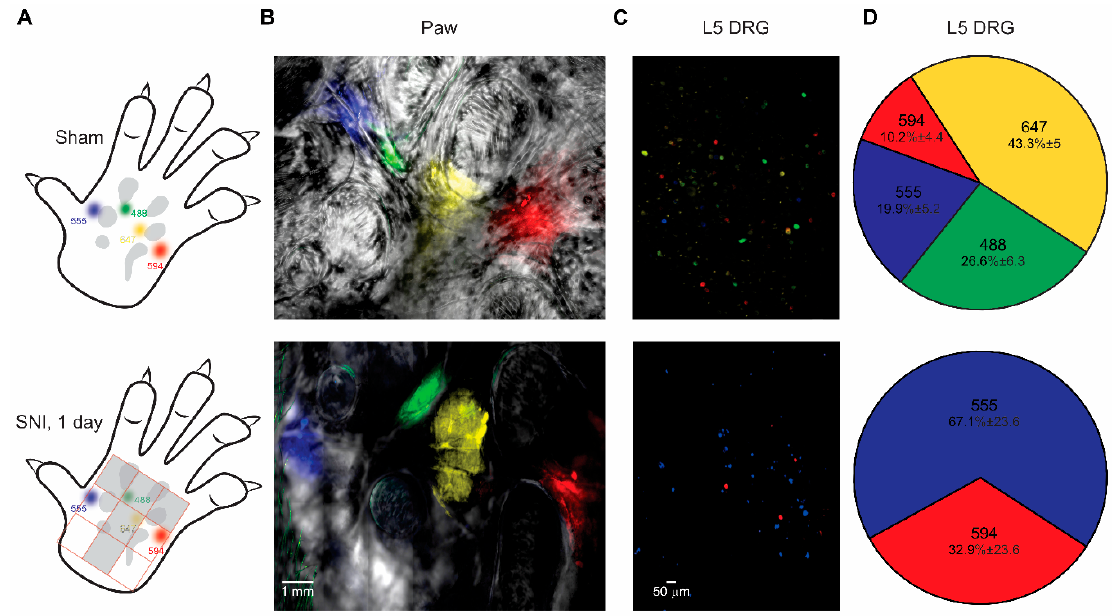
Figure 3. The Painbow detects changes in innervation. ( A ) Scheme representing the injection arrangement. The four dyes were injected into the paw one day after either sham (upper panel) or SNI (lower panel) surgery. The dyes were injected to sham and SNI groups in a similar arrangement and in accordance with the denervation pattern (depicted in the lower panel, as a grey “T-shaped” area), such that AF555 and AF594 were injected into medial and lateral areas (respectively) of the paw that does not undergo denervation. AF488 and AF647 were injected into the areas which were denervated after SNI. ( B ) Representative fluorescent images of the skin demonstrating the arrangement of the injections one day after sham surgery (upper panel) and 1 day after SNI (lower panel). A representative of six rats for sham and SNI groups ( C ). Representative fluorescent images of L 5 DRGs from sham-operated (upper panel) and SNI (lower panel) rats, removed 40 h after dyes were injected into the skin. Note that in DRG from a sham-operated animal, all colors are present, whereas in DRG from the animal after SNI, only colors injected into areas that are not underwent denervation (AF555 (blue) and AF594 (red)) are present. A representative of 6 rats for sham and SNI groups. ( D ) Distribution of dyes in L 5 DRGs from sham-operated animals (upper panel) and rat after SNI (lower panel). Note that in L 5 DRG from sham-operated rats the majority of the cells were labeled with AF647, but all colors were present, suggesting that L 5 DRG neurons send their axons into all labeled skin areas shown in A . In animals after SNI no cells labeled with the dyes injected into the denervated areas were found, n = 6 rats in each group.